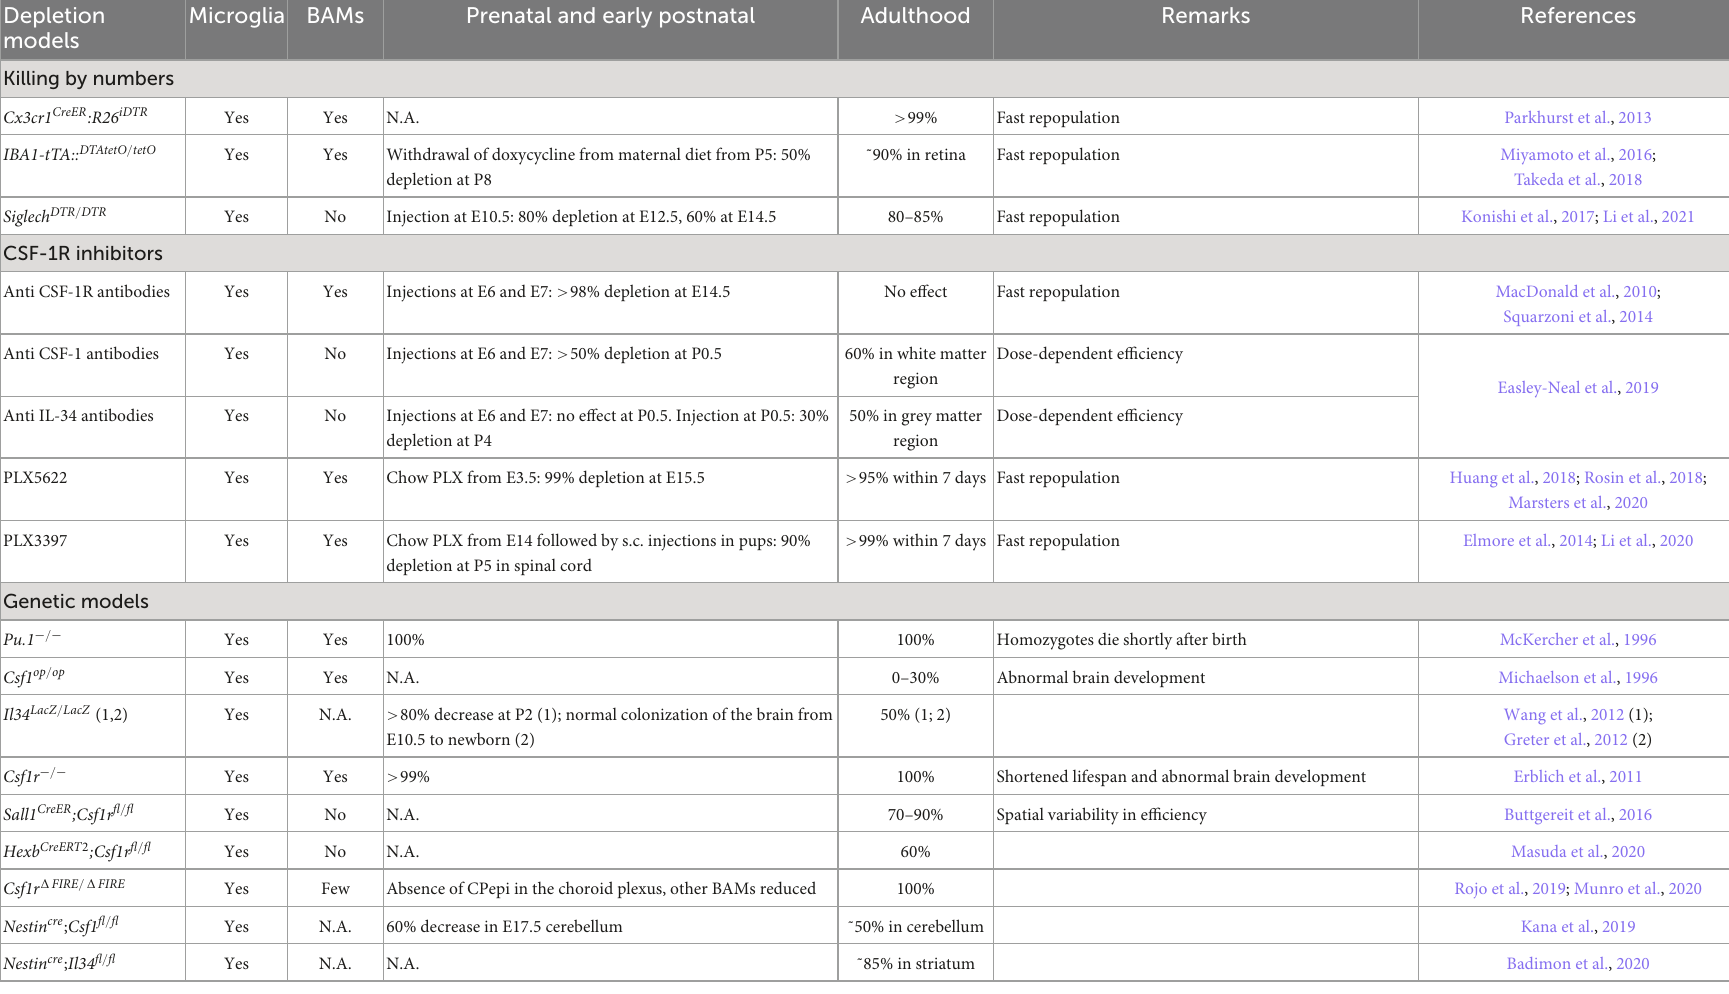
Table summarizing the main mouse lines and tools available to label, target and deplete microglia and BAMs, indicating their specificity and efficiency in development and adulthood. BAMs, border-associated macrophages; BM, bone marrow; CNS, central nervous system;CPepi,Kolmer’sepiplexus;DTA,diphtheriatoxinfragmentA;DTR,diphtheriatoxinreceptor;iDTR,induciblediphtheriatoxinreceptor;i.p.,intraperitoneal;N.A.,non-applicable;PVM,perivascularmacrophages;s.c.,subcutaneous;Tam,tamoxifen;40H-Tam,